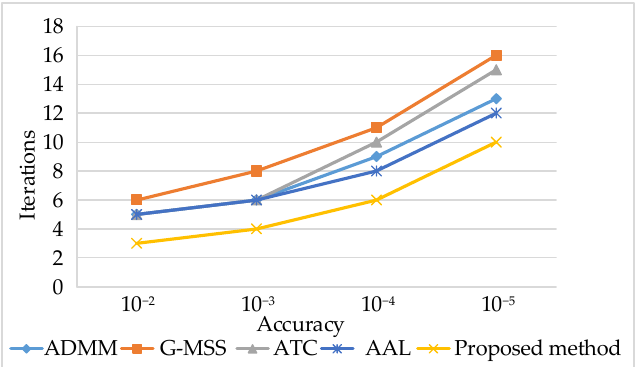
Figure 7. Iterations of various algorithms under different accuracy.